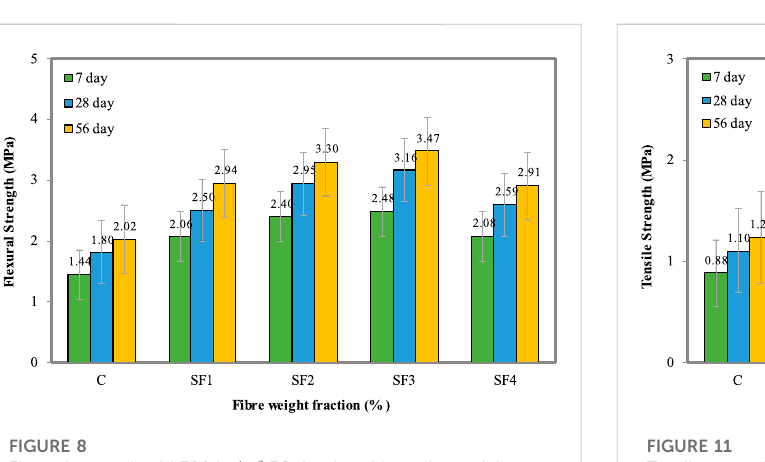
FIGURE 11 Tensile strength of 1,300 kg/m 3 FC density with varying weight fractions of SF.